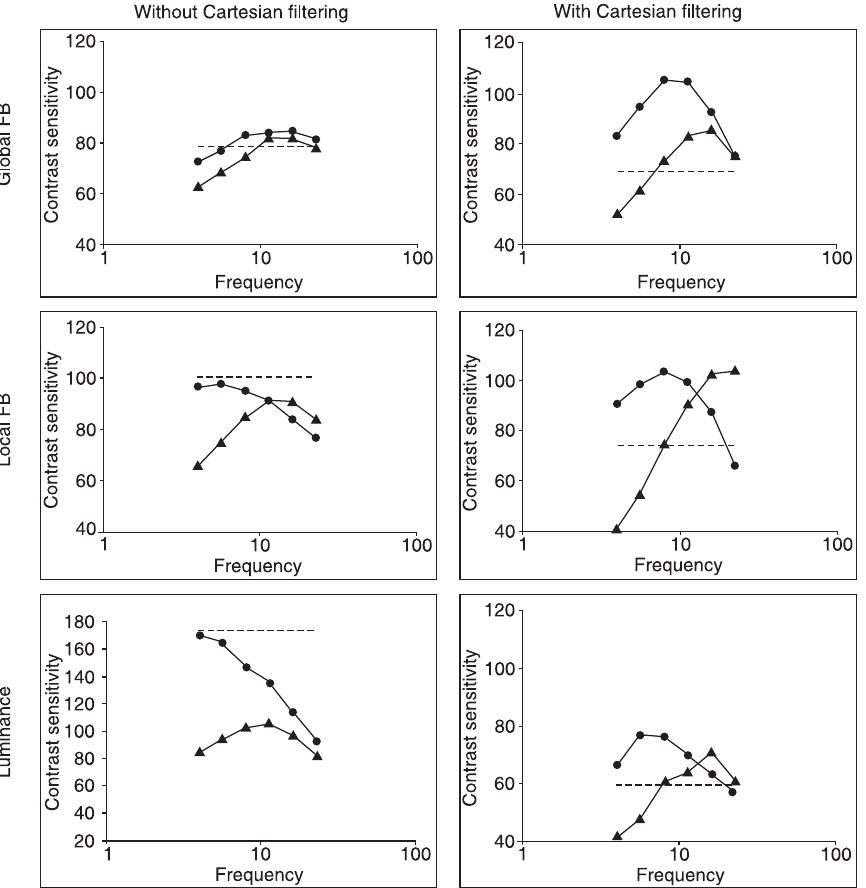
Figure 5. Face recognition con- trast sensitivity functions of the computational models without (left panels) and with (right pan- els) local Cartesian filtering. Top row, Global Fourier-Bessel (FB)-based model. Middle row, Local FB-based model. Bottom row, Luminance-based model. Circles and triangles represent radial and angular stimulus fil- tering, respectively. Each point represents the mean of 5 meas-